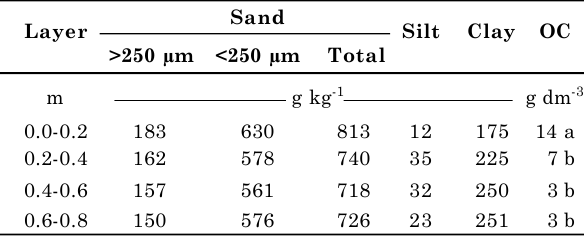
Table 1. Particle size distribution and organic carbon (OC) content of the soil in a citrus orchard